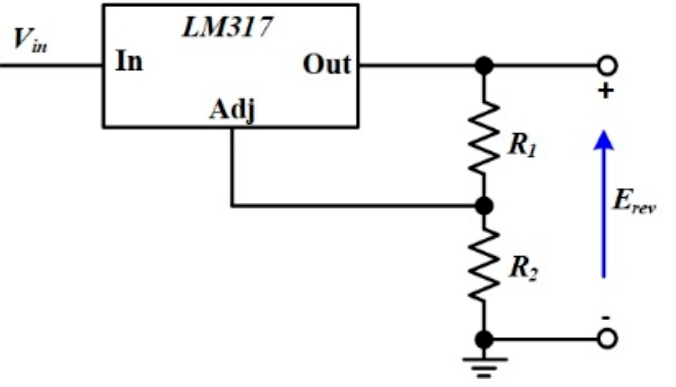
Figure 6. Voltage regulator configuration.